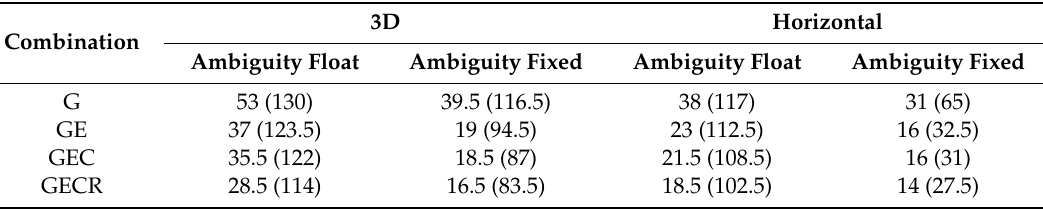
Table 4. Convergence times (min) to achieve 10 cm positioning accuracy of the 3D and horizontal components of di ff erent combinations in a 90% probability (numbers in brackets are the criterion of 1